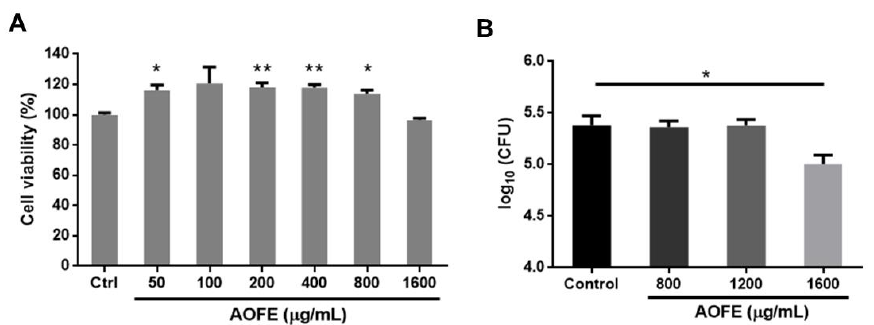
Figure 3. Effect of AOFE on the invasion of Mp in A549 cells. ( A ) A549 cells were treated with different concentrations of AOFE for 20 h, and cell viability was assessed by MTT assay. Untreated cells served as the control. The data shown are representative of three independent experiments ( n = 3). ( B ) A549 cells were pre-treated with AOFE at indicated concentrations for 2 h, followed by Mp infection (MOI = 100) for 24 h. The amount of Mp internalized into A549 cells was determined by the gentamicin protection assay and qPCR, as described in the Materials and Methods. The results shown are representative of two independent experiments with similar results ( n = 3). * p < 0.05, ** p < 0.01 versus the controls.